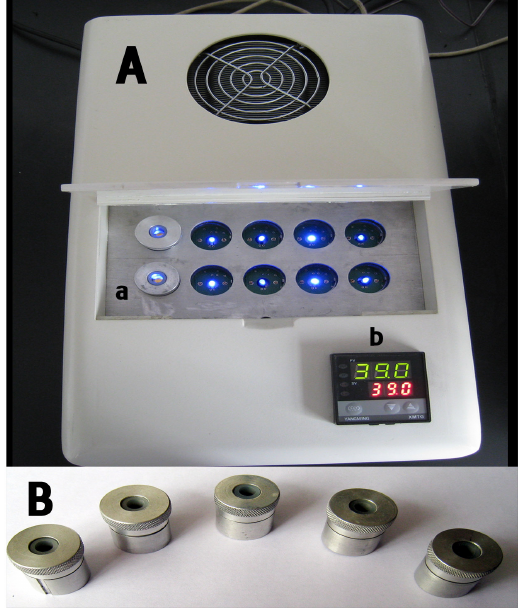
Figure 1. 2×5 QCM nucleic acid biosensor array and detection wells. (A) Picture of QCM nucleic acid biosensor array detector. 2×5 detection wells and thermal controller system are indicated as follows: (a) 2×5 detection well array, (b) thermal controller system. (B) Picture of five detection